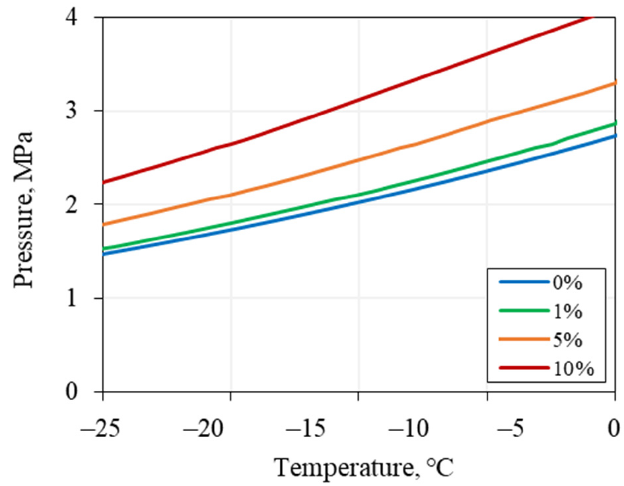
Figure 6. Pressure and temperature conditions of hydrate stability in a free volume at different NaCl concentrations ( HydraFlash modeling).